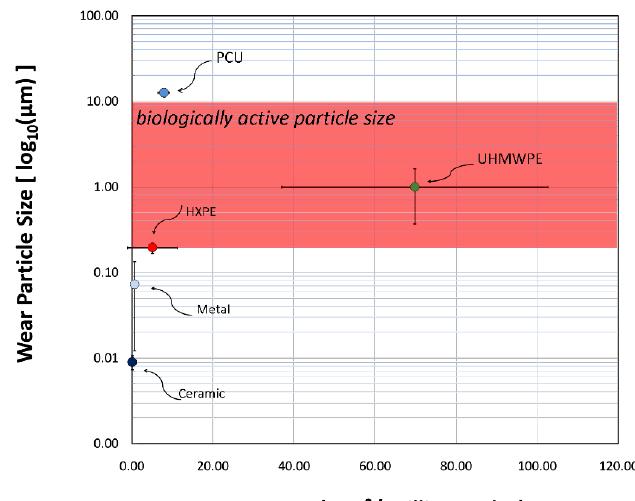
Figure 5. Comparison between typical wear particle sizes versus wear rates reported for various acetabular liners used in total hip replacement (THR). Data is presented based on the volumetric wear rate ( a ) and wear particle generation rate ( b ) [118]. Reprinted with permission from John Wiley & Sons, Inc.